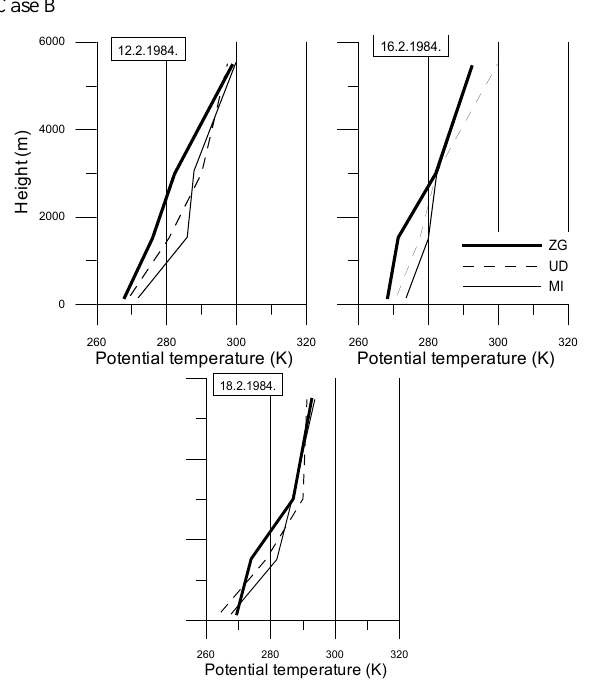
Fig. 9. Vertical profiles of potential temperature at Zagreb (ZG), Udine (UD) and Milano (MI) on 12, 16 and 18 February 1984 at 00 UTC.